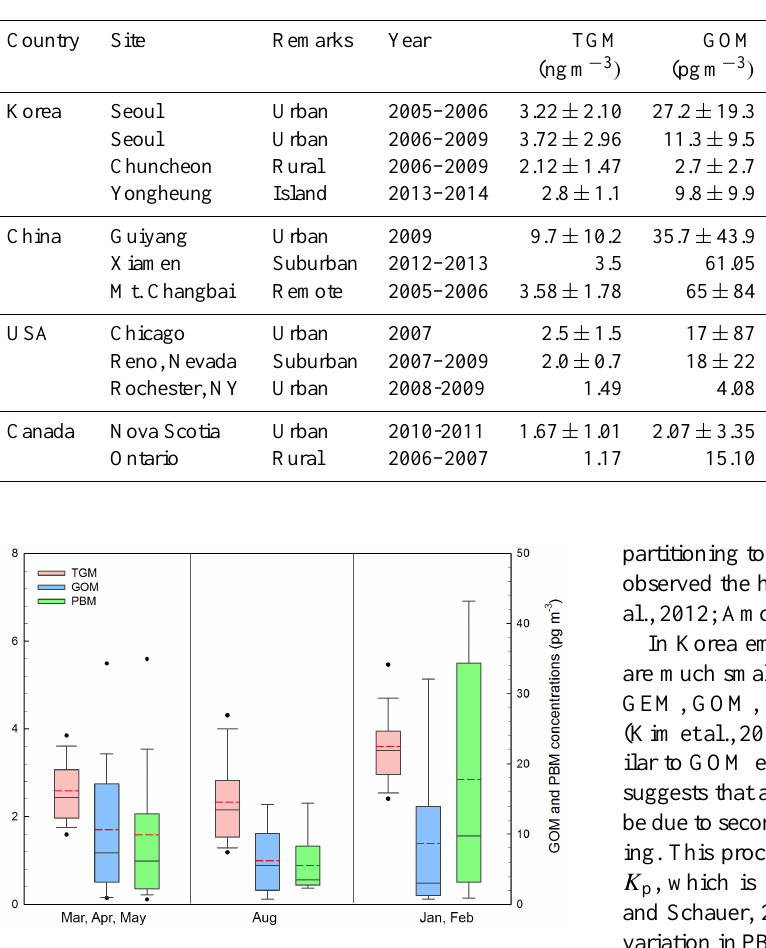
Figure 3. Box-and-whisker plot for the concentrations of TGM, GOM, and PBM during three different periods. The red dash lines indicate the arithmetic